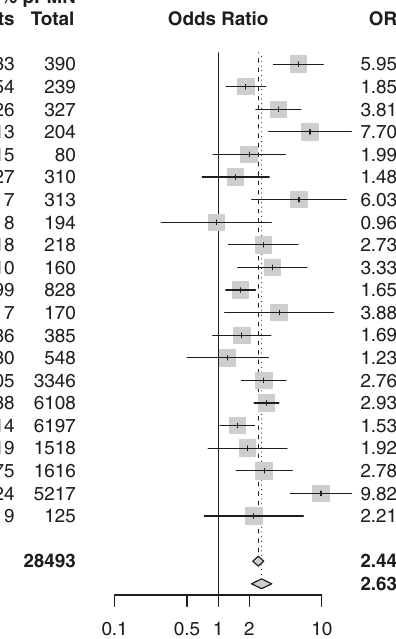
Fig. 4 | Meta-analysis of the prognostic value for mortality of >5% versus ≤ 5% pigment-containingpolymorphonuclearleukocytes(pPMN)in32,035patients clinically diagnosed with severe falciparum malaria. The individual point esti- mates (shaded squares with centered vertical ticks) and 95% con fi dence intervals